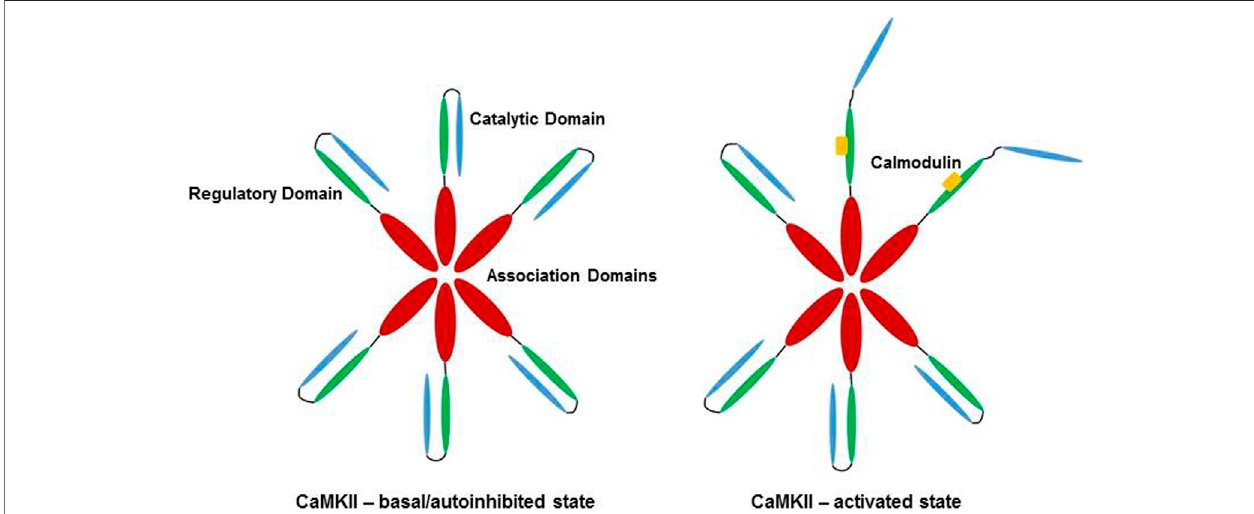
FIGURE 1 | Activation of CaMKII by Ca 2+ /CaM. In low Ca 2+ /CaM concentrations, the catalytic domain (blue) is autoinhibited by the regulatory domain (green). Subunits of the dodecamer are held together by the association domains (red). High Ca 2+ /CaM concentrations (yellow) lead to binding of Ca 2+ /CaM to the regulatory domain, releasing the catalytic domain of CaMKII and allowing for enzymatic activity. Veitch 2021, original